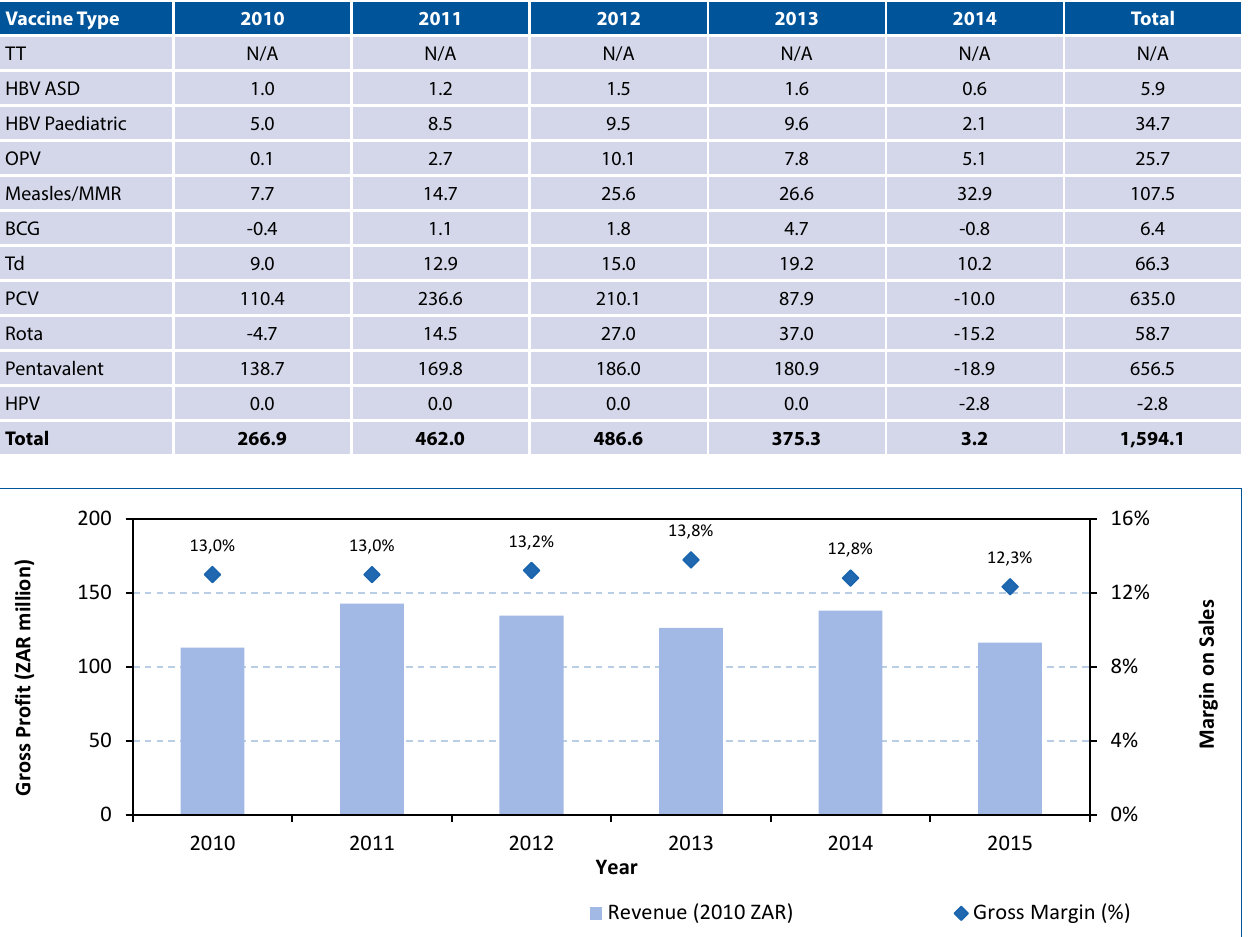
Figure 3. Gross profit and margin over the evaluation